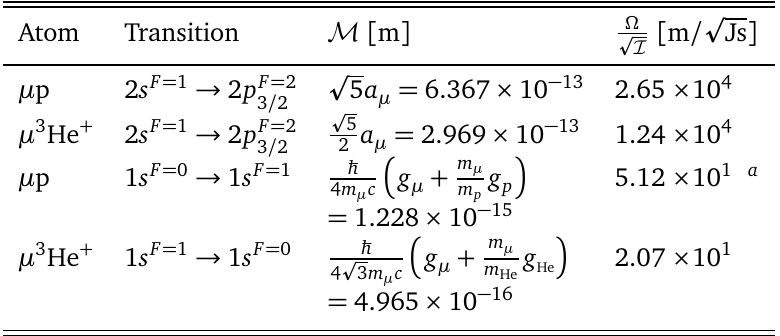
(cid:112) and Ω / for Lamb shift and HFS transitions in µ p and µ 3 He + M I